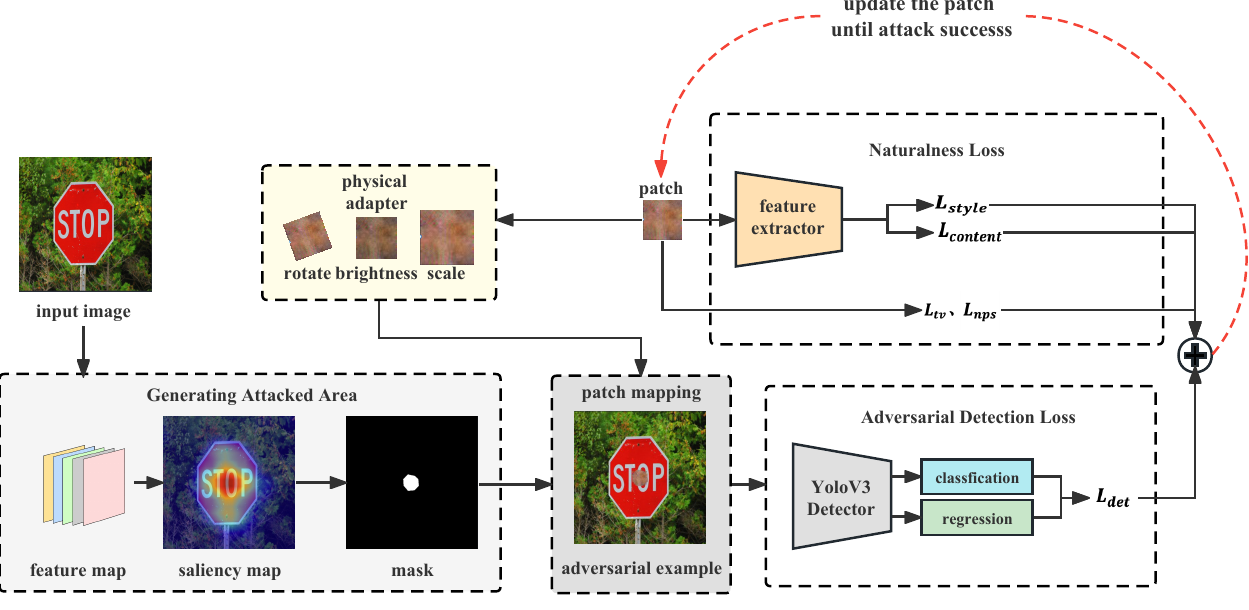
Figure 3. The framework of our